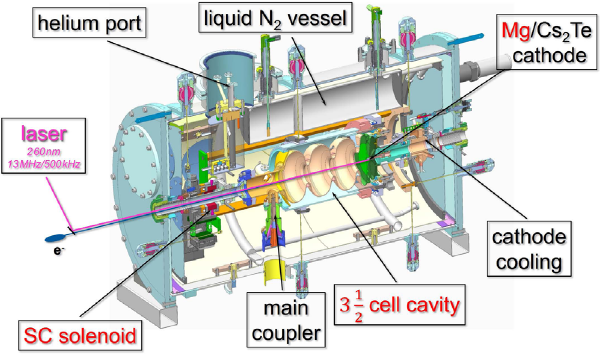
FIG. 1. Overview of the design of the ELBE SRF Gun